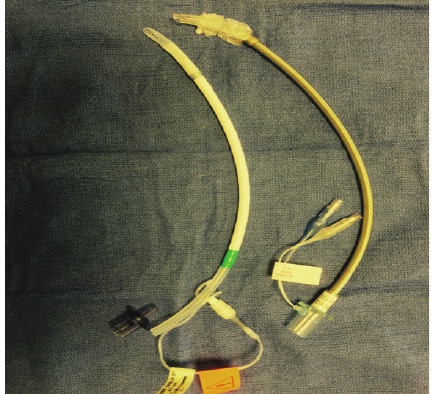
Figure 1: 4.5 mm ID Xomed Laser Shield II (left) and laser-safe (right) endotracheal